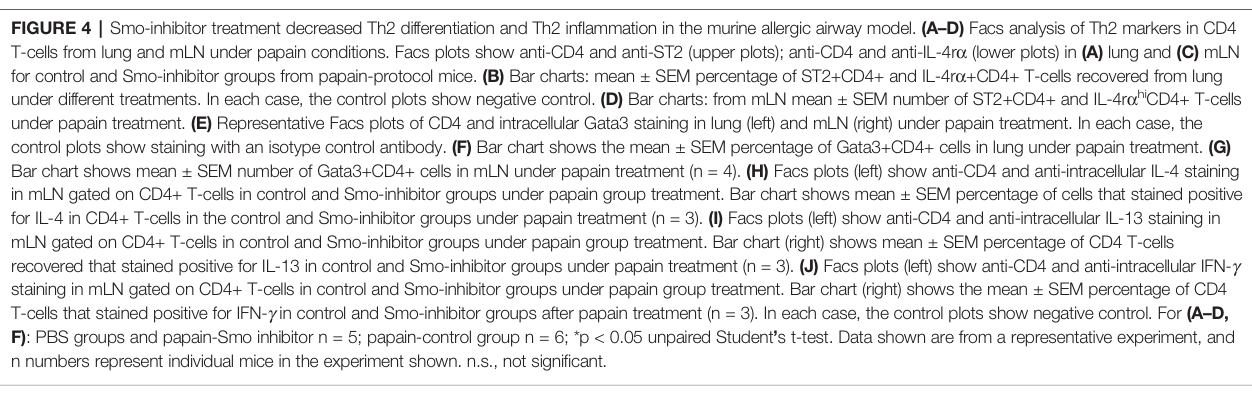
FIGURE 4 | Smo-inhibitor treatment decreased Th2 differentiation and Th2 in fl ammation in the murine allergic airway model. (A – D) Facs analysis of Th2 markers in CD4 T-cells from lung and mLN under papain conditions. Facs plots show anti-CD4 and anti-ST2 (upper plots); anti-CD4 and anti-IL-4r a (lower plots) in (A) lung and (C) mLN for control and Smo-inhibitor groups from papain-protocol mice. (B) Bar charts: mean ± SEM percentage of ST2+CD4+ and IL-4r a +CD4+ T-cells recovered from lung under different treatments. In each case, the control plots show negative control. (D) Bar charts: from mLN mean ± SEM number of ST2+CD4+ and IL-4r a hi CD4+ T-cells under papain treatment. (E) Representative Facs plots of CD4 and intracellular Gata3 staining in lung (left) and mLN (right) under papain treatment. In each case, the control plots show staining with an isotype control antibody. (F) Bar chart shows the mean ± SEM percentage of Gata3+CD4+ cells in lung under papain treatment. (G) Bar chart shows mean ± SEM number of Gata3+CD4+ cells in mLN under papain treatment (n = 4). (H) Facs plots (left) show anti-CD4 and anti-intracellular IL-4 staining in mLN gated on CD4+ T-cells in control and Smo-inhibitor groups under papain group treatment. Bar chart shows mean ± SEM percentage of cells that stained positive for IL-4 in CD4+ T-cells in the control and Smo-inhibitor groups under papain treatment (n = 3). (I) Facs plots (left) show anti-CD4 and anti-intracellular IL-13 staining in mLN gated on CD4+ T-cells in control and Smo-inhibitor groups under papain group treatment. Bar chart (right) shows mean ± SEM percentage of CD4 T-cells recovered that stained positive for IL-13 in control and Smo-inhibitor groups under papain treatment (n = 3). (J) Facs plots (left) show anti-CD4 and anti-intracellular IFN- g staining in mLN gated on CD4+ T-cells in control and Smo-inhibitor groups under papain group treatment. Bar chart (right) shows the mean ± SEM percentage of CD4 T-cells that stained positive for IFN- g in control and Smo-inhibitor groups after papain treatment (n = 3). In each case, the control plots show negative control. For (A – D, F) : PBS groups and papain-Smo inhibitor n = 5; papain-control group n = 6; *p < 0.05 unpaired Student ’ s t-test. Data shown are from a representative experiment, and n numbers represent individual mice in the experiment shown. n.s., not signi